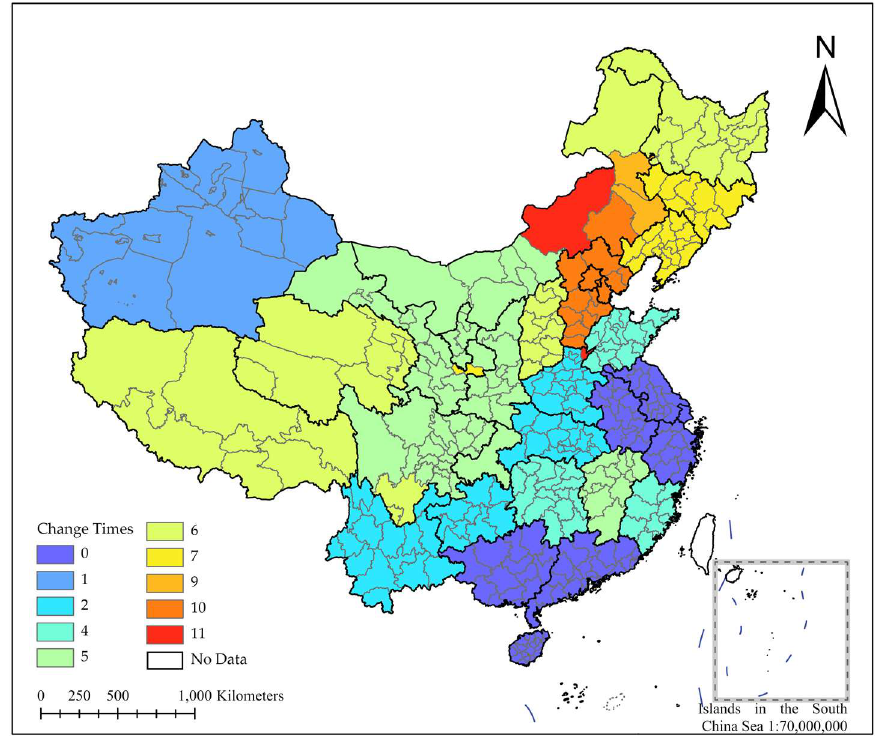
Figure 10. The change times in urban community affiliation for each city.